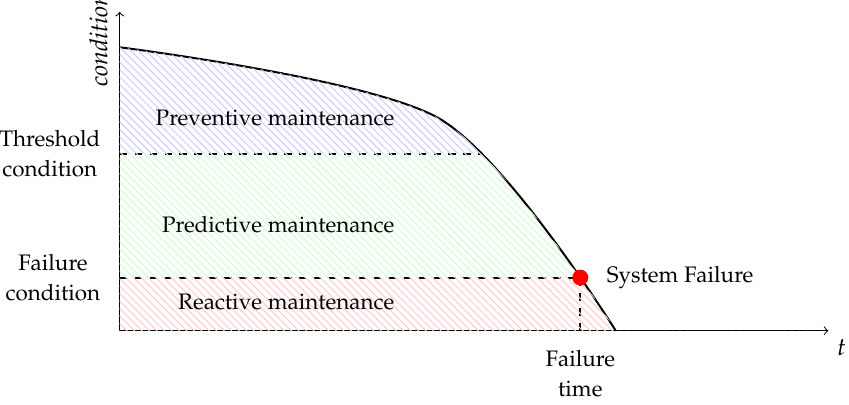
Figure 6. Difference between maintenance approaches in terms of condition and